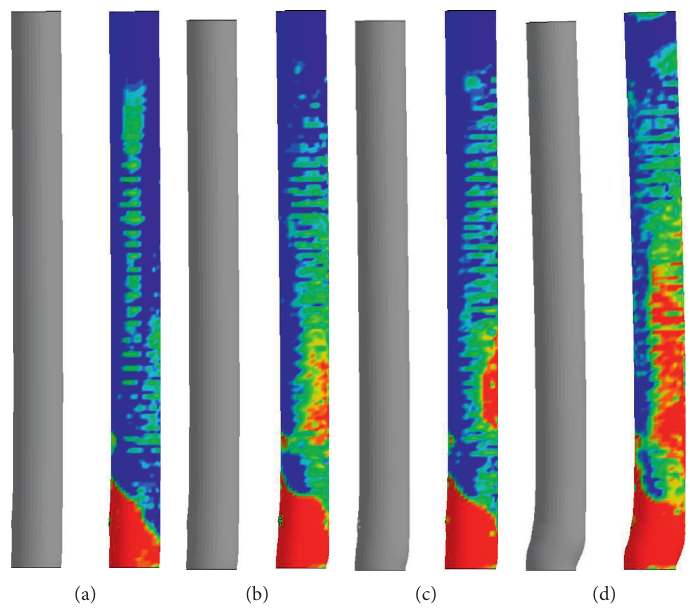
Figure 12: Shape of bridge column after vehicle collision (column type IV)). (a) 100km/h. (b) 110km/h. (c) 120km/h. (d) 130km/h.